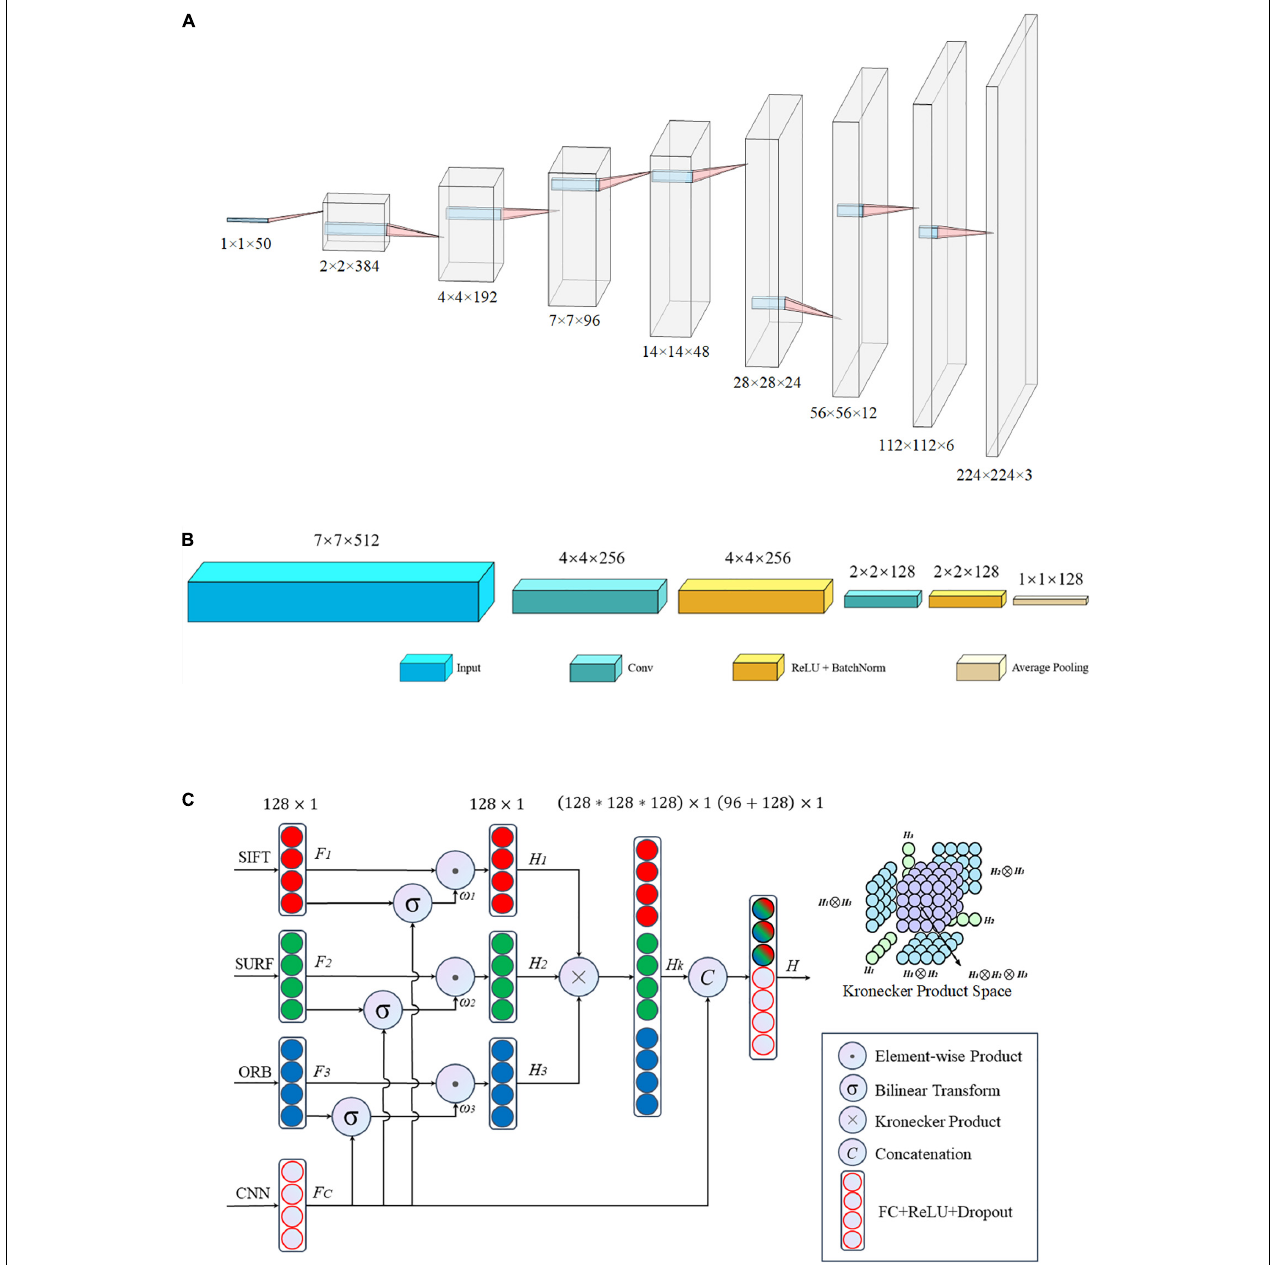
FIGURE 5 | Architecture of the proposed network: (A) matching network, (B) fallen network, and (C) gated information fusion network. The upper right corner of panel (C) is the Kronecher space of interactions among three features H 1 , H 2 , and H 3